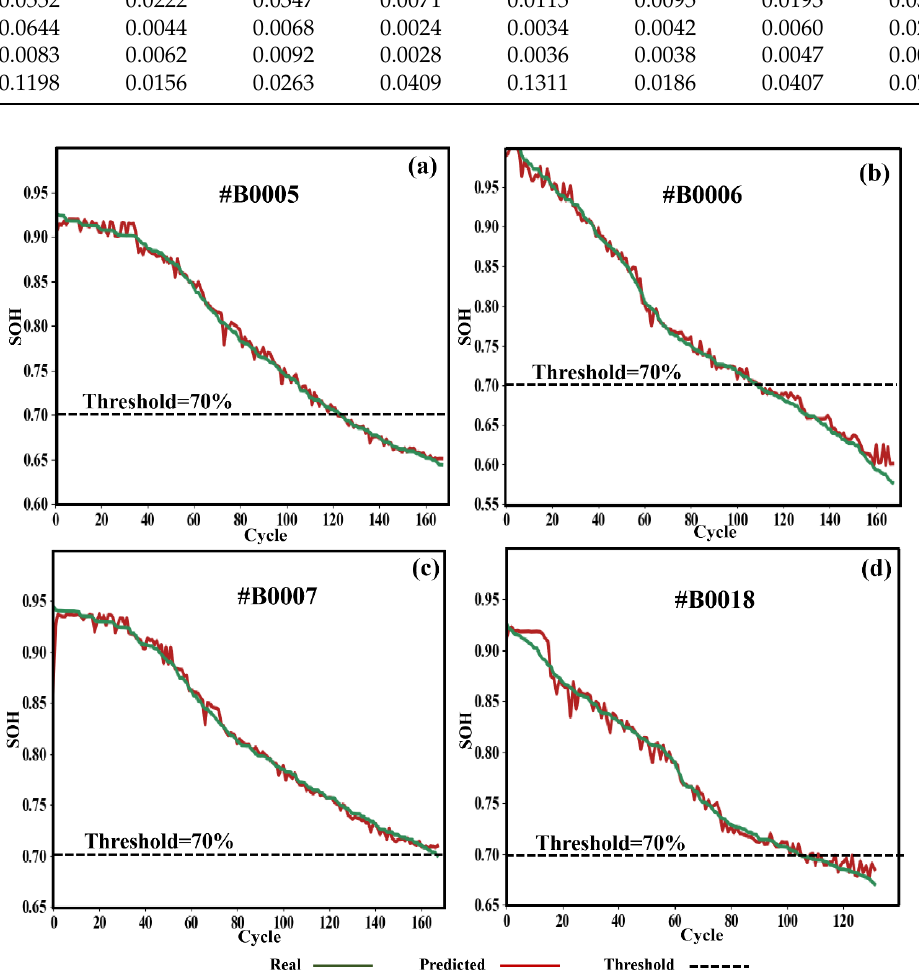
Figure 2. The real and estimated SOH of batteries #5 ( a ), #6 ( b ), #7 ( c ), and #18 ( d ), discharged at 2A and 24 ° C, respectively.